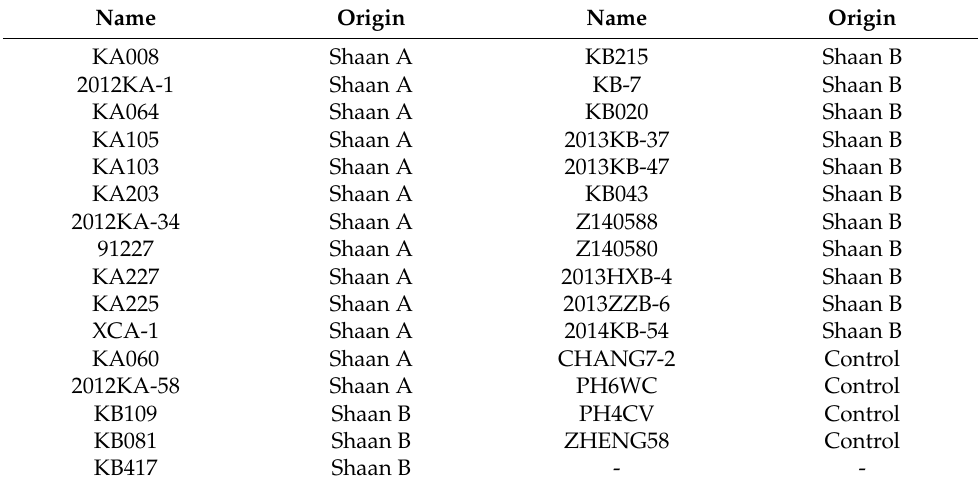
Table 1. Code of tested maize inbred lines and their